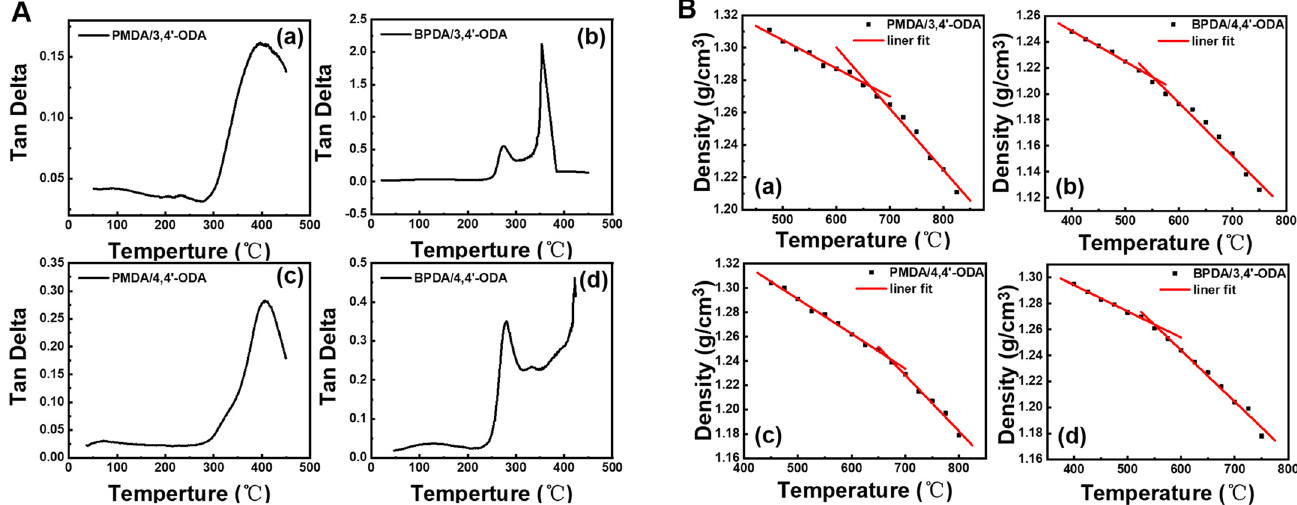
Figure 11. ( A ) The DMA curves of different systems of PI; ( B ) Tgs of PI obtained by